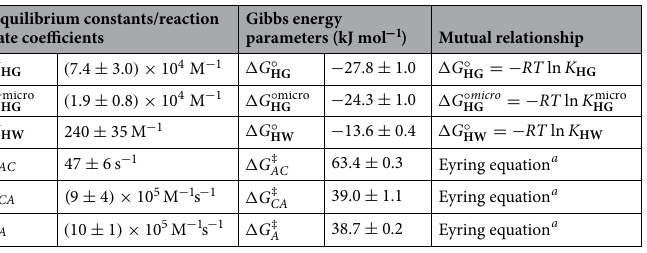
a In the Eyring equation, the assumption for